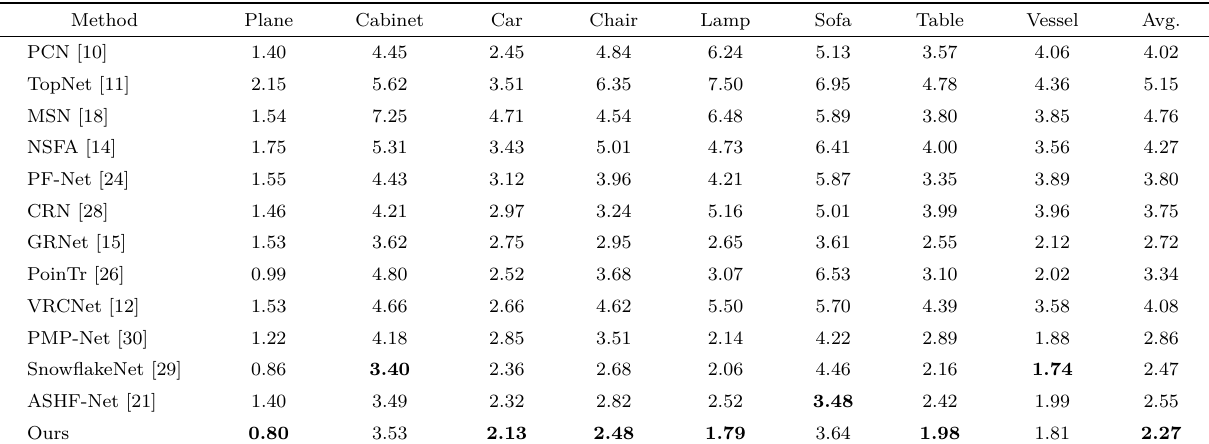
Table 1 Shape completion results (CD loss × 10 4 ) on the ShapeNet